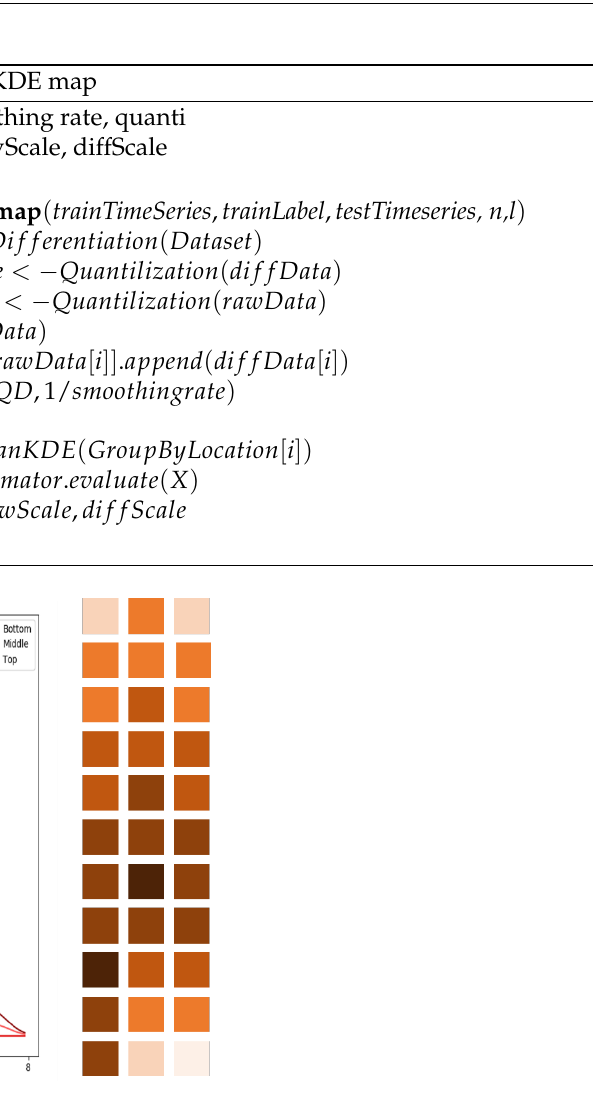
Figure 4. 2D KDEmap example. ( Left ) KDEmap represented by three consecutive probability density function. ( Right ) KDEmap where three discrete function are represented by a